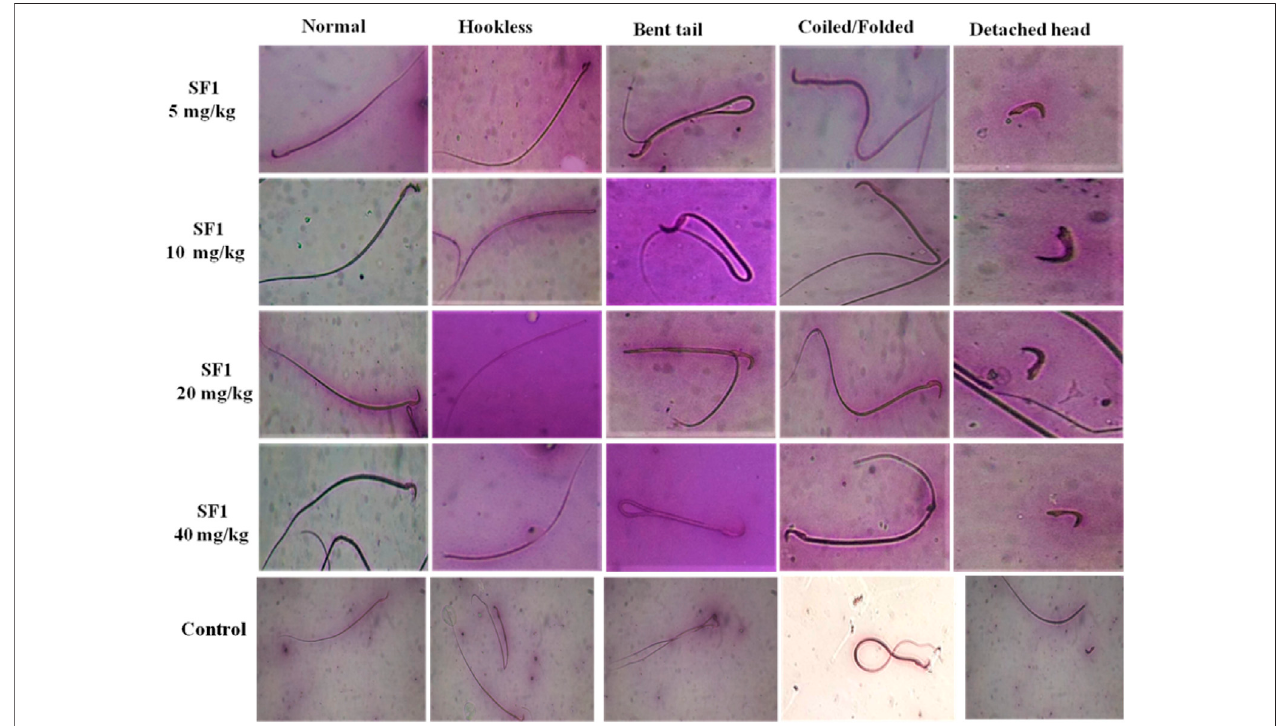
FIGURE 5 | Pictorialrepresentationofspermmorphology(benttail,coiledanddetachedhead) aftertreatmentwithdifferentSF1doselevelsinsubacutetoxicitystudy.